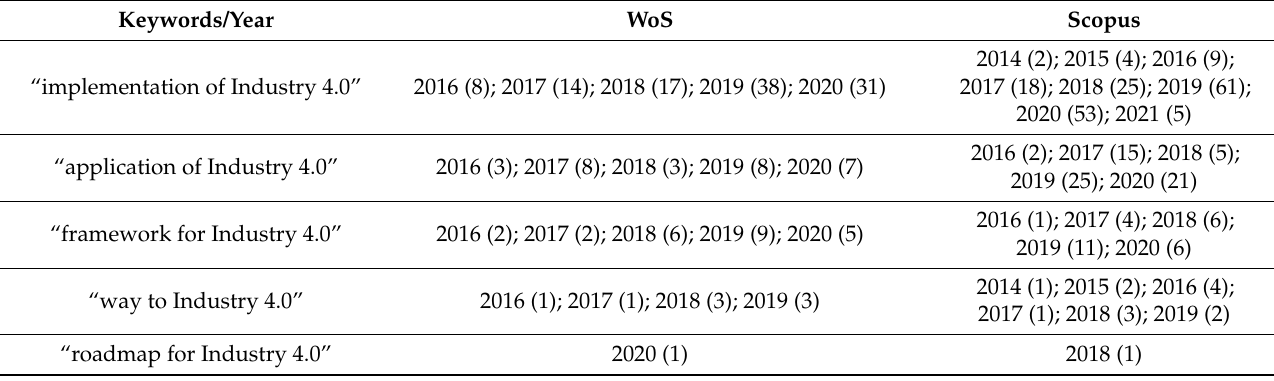
Table 3. Results of own literature review in the field